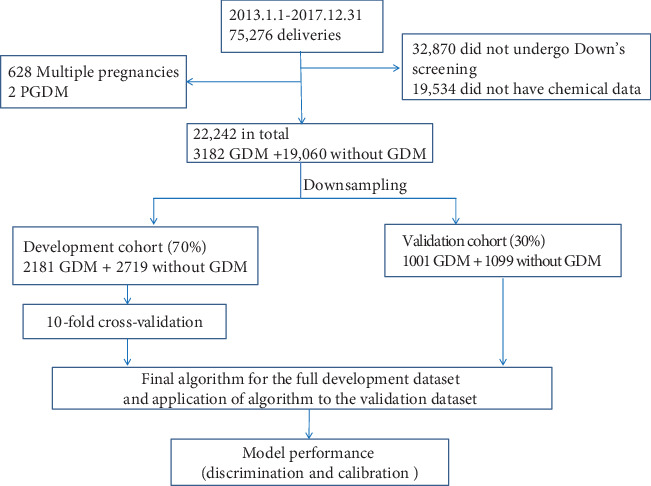
Study profile and analysis pipeline.